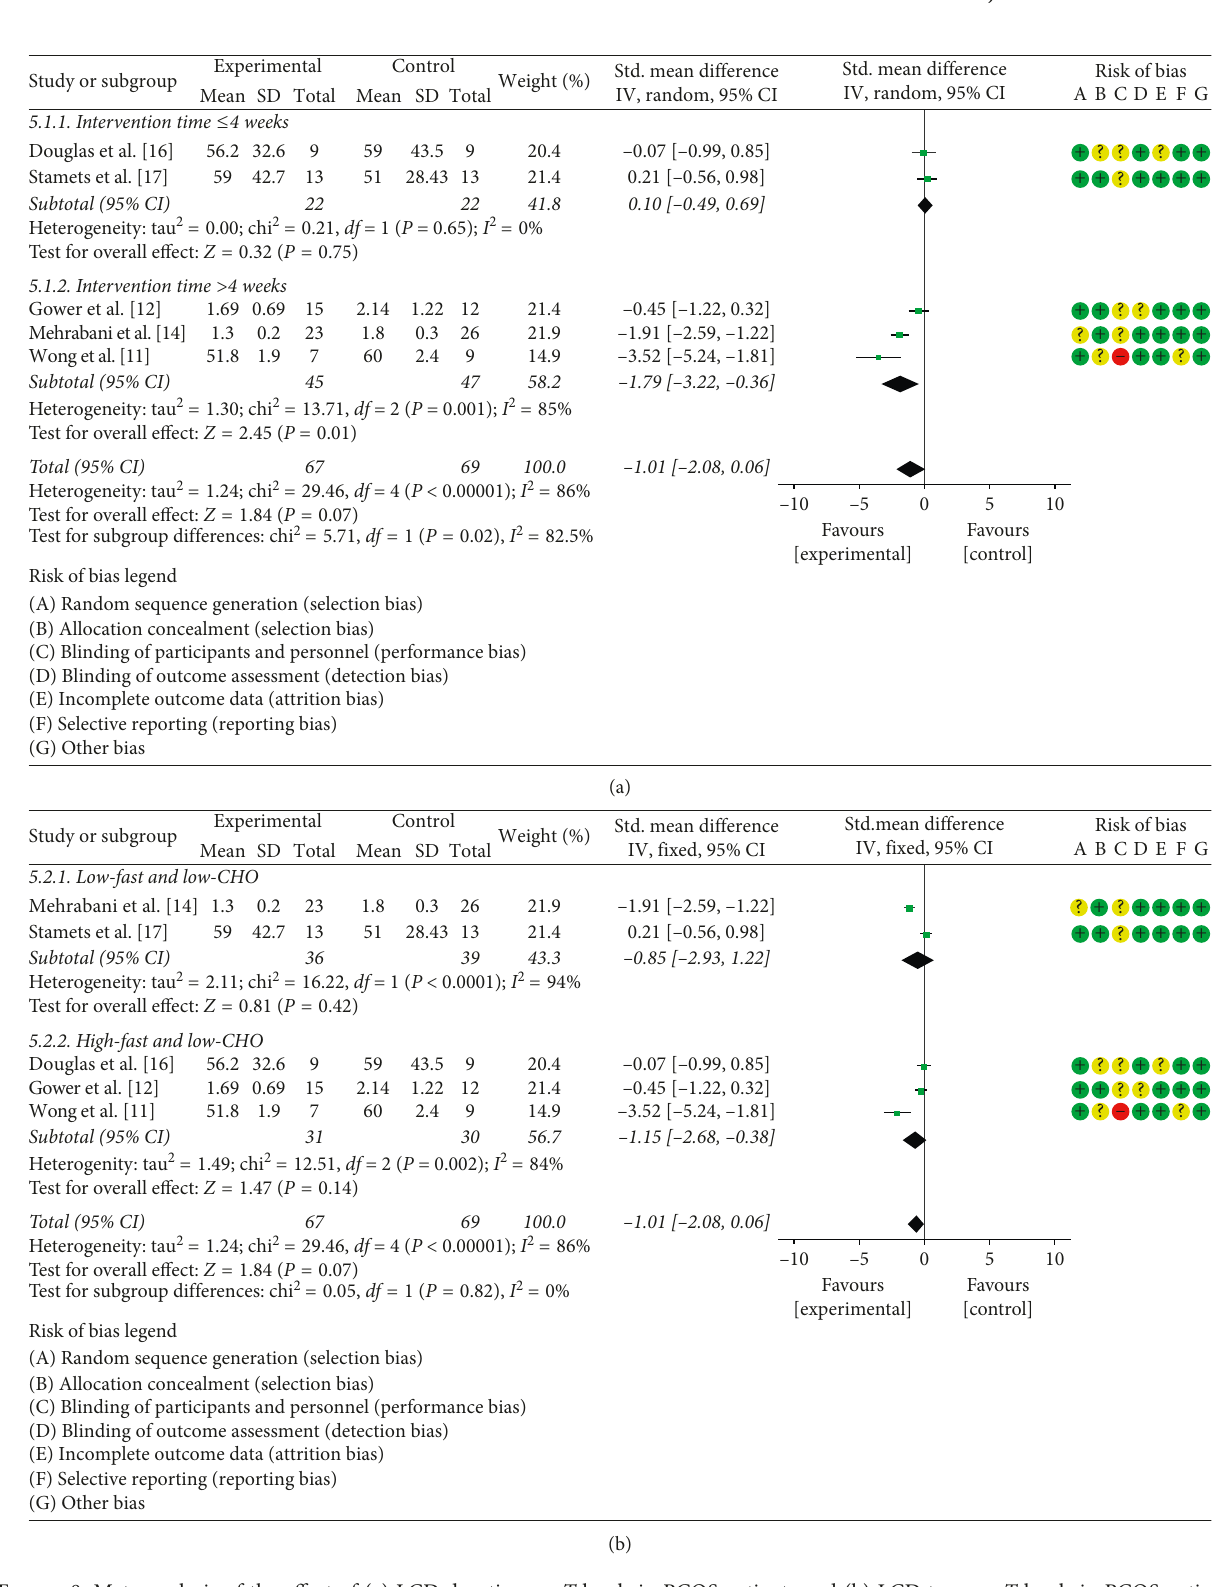
Figure 8: Meta-analysis of the effect of (a) LCD duration on T levels in PCOS patients and (b) LCD type on T levels in PCOS